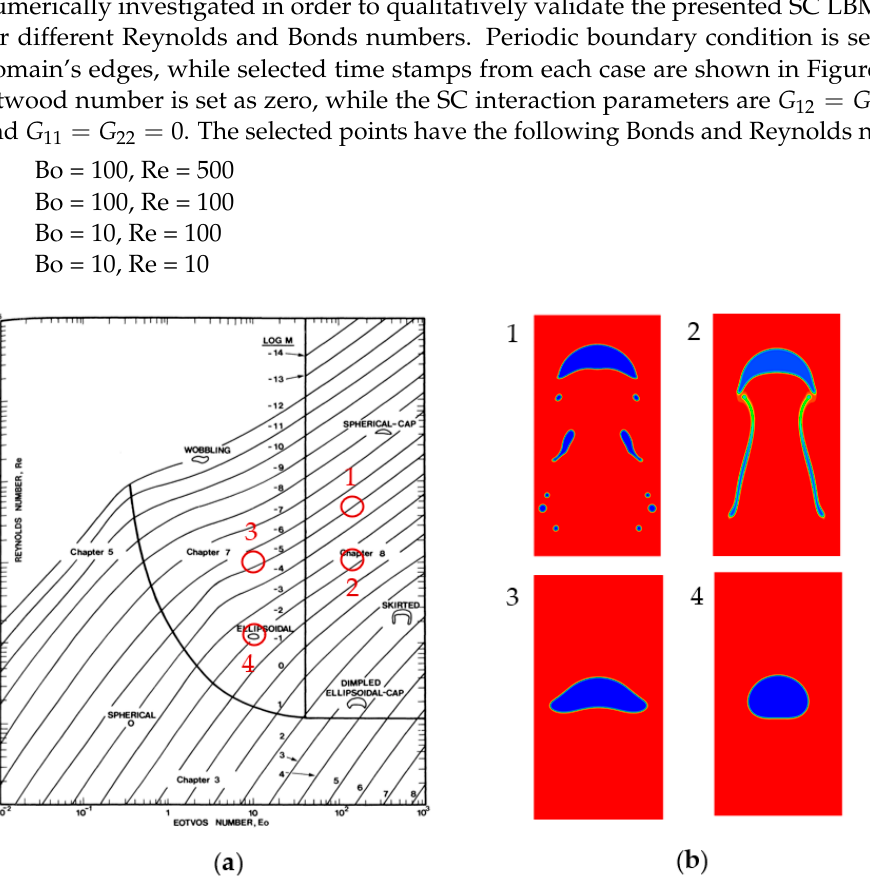
Figure 5. ( a ) Shape regimes for bubble rise after Clift et al. [29]. ( b ) Four simulation samples from different points on the diagram .